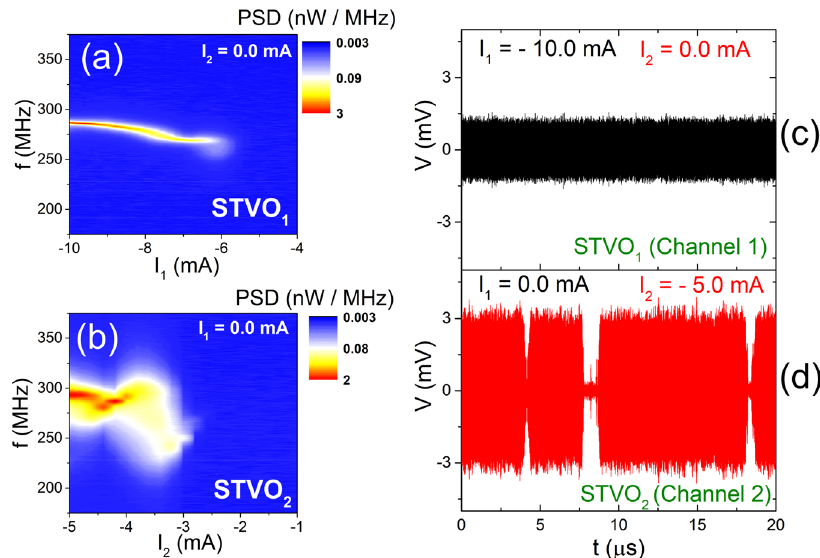
Fig. 2 Dynamics of individual oscillators. a , b Power spectral density (PSD) individually measured from two spin torque vortex oscillators (STVO 1 and STVO 2 ) with an edge-to-edge distance of 100 nm. a Spectrum obtained for STVO 1 as a function of the direct current I 1 (the direct current I 2 applied to STVO 2 is kept at zero). b Spectrum obtained for STVO 2 as a function of I 2 (I 1 is kept at zero). c Time trace obtained for STVO 1 at I 1 = − 10.0 mA. d Time trace obtained for STVO 2 at I 2 = − 5.0 mA. Each time trace is presented after application of a band pass fi lter between 150 MHz and 400 MHz to include only the gyrotropic oscillation. A perpendicular magnetic fi eld of 2.8 kOe was applied during the